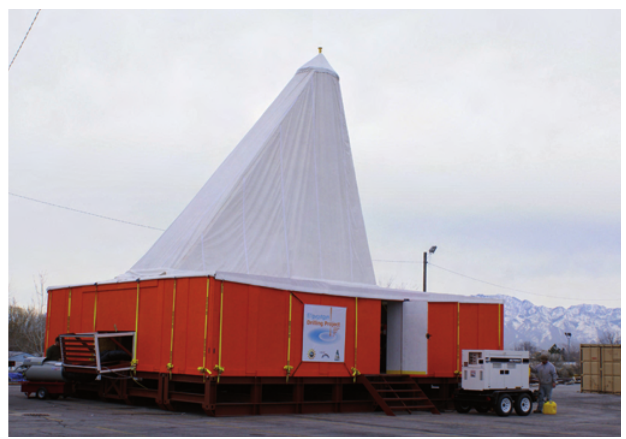
Figure 2. The new “Russian”GLAD assembled and modified by DOSECC in Salt Lake City in consultation with Alex Pyne (Antarctica Research Center, New